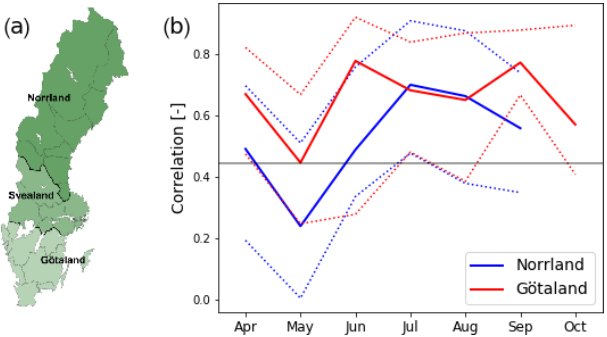
Figure 4. (a) Map of Sweden with the three regions used in this study and (b) correlation of FWI (ERA-Interim and monthly max- imum value with a 7d running mean applied) with the observed burnt area for Norrland and Götaland from 1998 to 2017. For Svealand there were not enough forest fires for this analysis. The dotted lines represent the 5%–95% bootstrapped confidence inter- vals, and the grey line indicates the significance threshold of 5%. The observed burnt area is from Swedish governmental data (MSB,